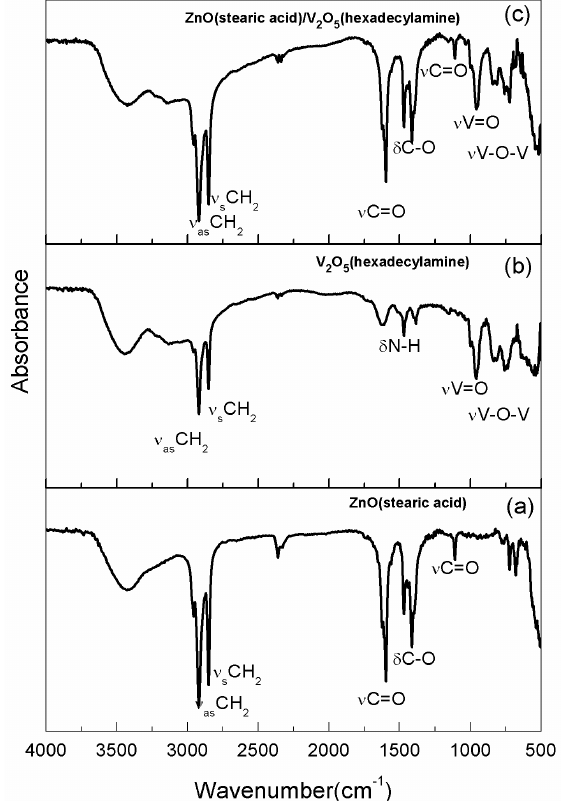
Figure 4. ( a ) FTIR absorbance spectra of ZnO(SA) ( b ) FTIR absorbance spectra of V 2 O 5 (HDA) and ( c ) FTIR spectra of ZnO(SA)/V 2 O 5 (HDA).